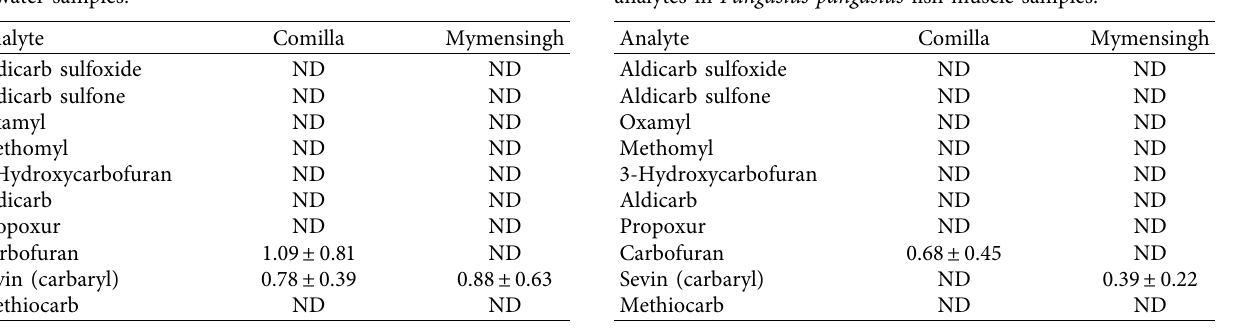
Table 6: Mean concentration ( μ g/kg) ± SD of detected carbamate analytes in Pangasius pangasius fish muscle samples.